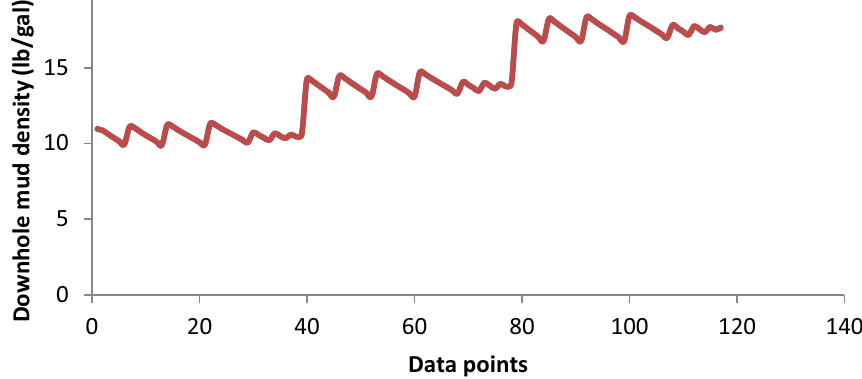
Fig. 3 Comparison between model prediction and experi- mental data